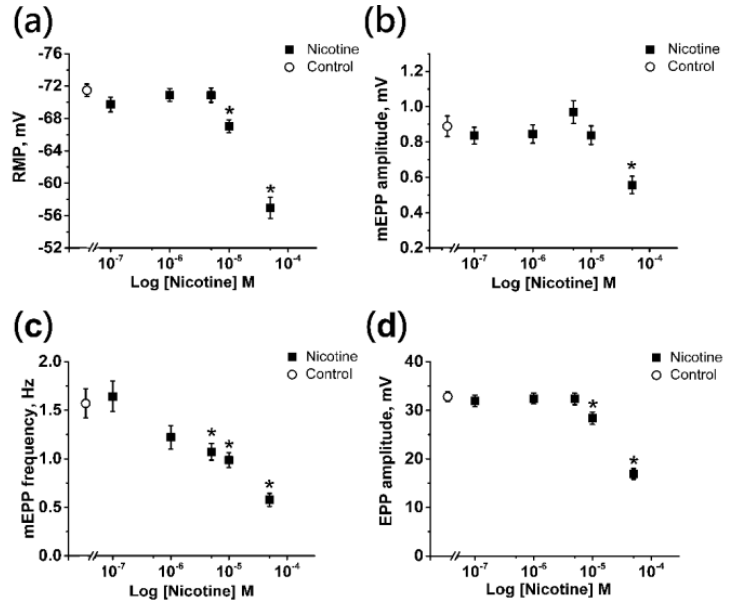
Figure 1. Effects of nicotine on the electrophysiological parameters registered at the mouse neuro- muscular junction. Changes in absolute values are shown ( a ) resting membrane potential (RMP) of muscle fibers, ( b ) amplitudes of miniature endplate potentials (mEPP), ( c ) frequency of the mEPPs, and ( d ) the amplitudes of evoked endplate potentials (EPP) in the control and 15 min after nicotine application (the range from 0.1 to 50 μM). Results are expressed as mean ± SEM. Asterisk s (*) indi- cate significant effects ( p < 0.05, one- way ANOVA test with Dunnet’s post -hoc comparison).